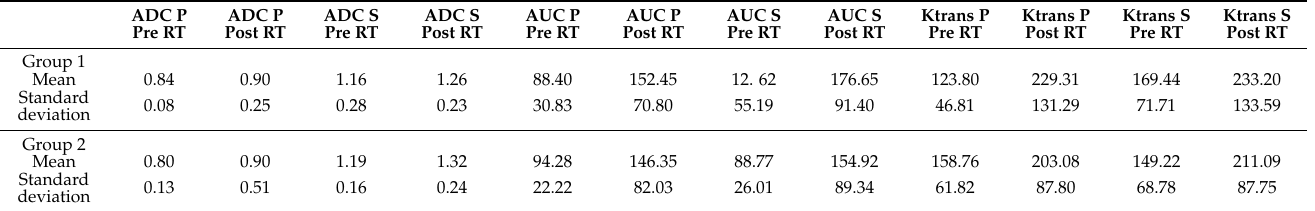
Table 3. Mean, median, and standard deviation for the parameters studied in group 1 (mild xeros- tomia) and group 2 (moderate xerostomia) on DWI and DCE-PWI sequences. P = parotid gland. S = submandibular gland.